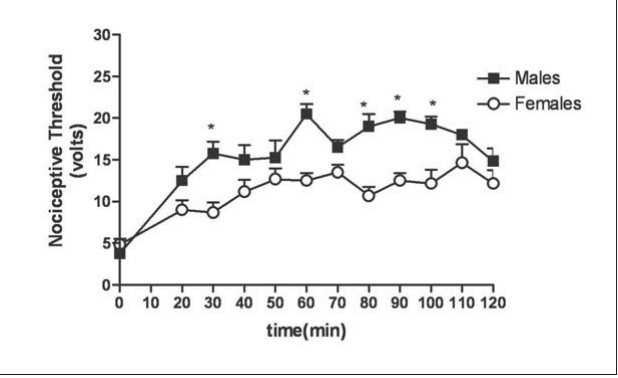
Fig. 4. Male-female differences in the analgesic effect of low-frequency electroacupuncture (EACP) in rabbit tooth pulp assay. The nociceptive threshold was measured before and after EACP procedure every 10 min up to 120 min. Males and females were treated with EACP (Yintang, ST4, ST5 acupoints; 2 Hz, 30 mA; 20 min before test up to 120 min). The points represent the means ± SEM of 6 animals per group. Asterisks indicate statistically significant differences between males and females (*p<0.05; Student’s t-test).